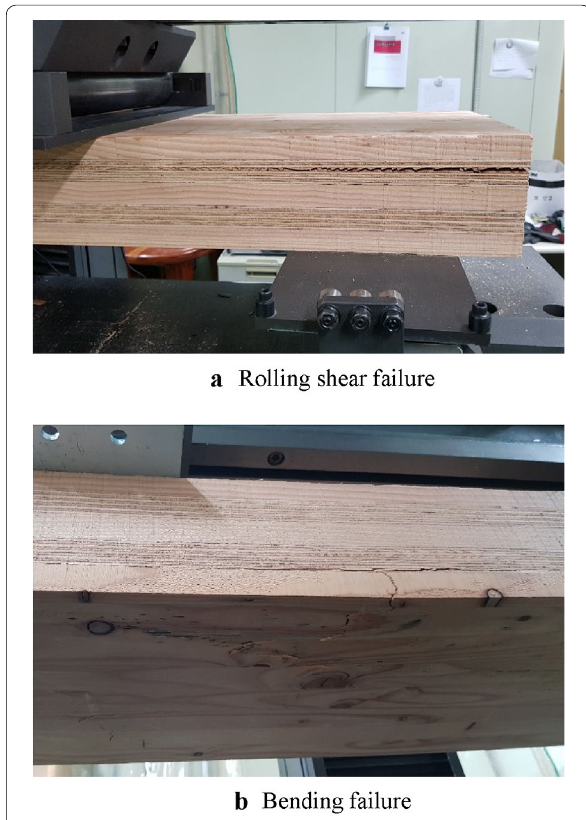
Fig. 7 Failure modes in specimens with low span‑to‑depth ratio (12:1)